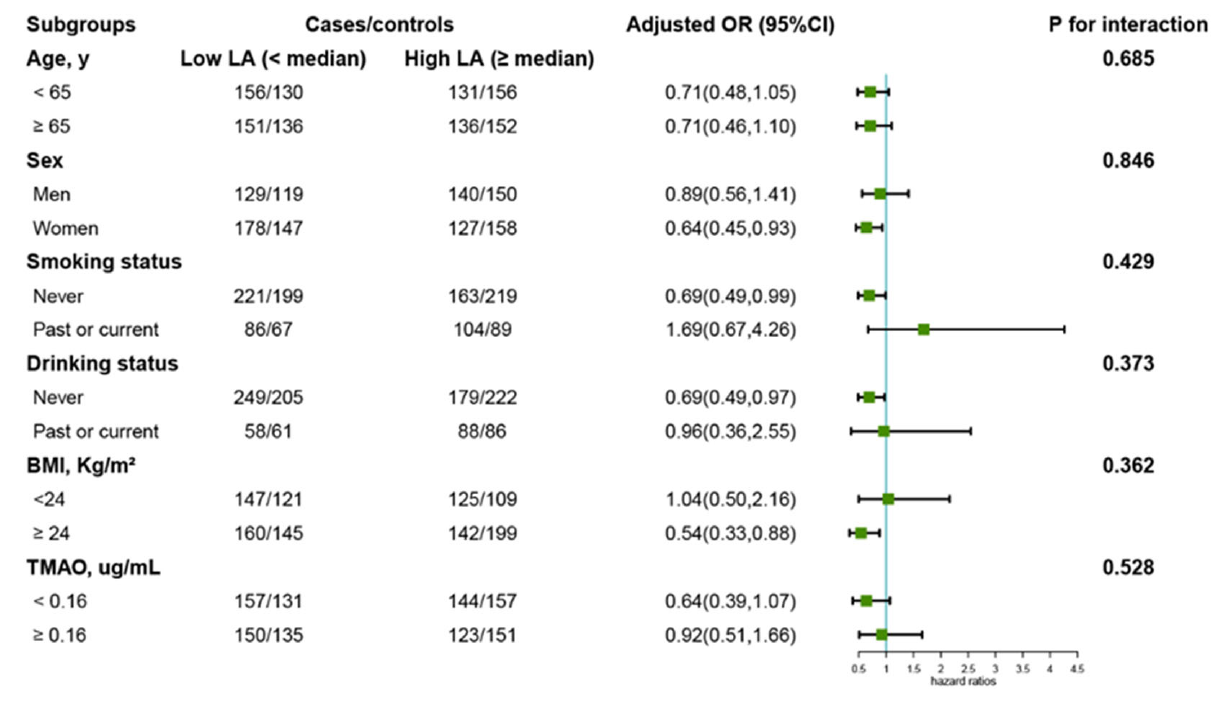
Figure 3. Stratified analysis of the association of serum LC with the risk of overall cancer. Note: Models were adjusted for ALT, ALB, BMI, smoking status, alcohol drinking, SBP, TC, TG, UA, HDL-C, glucose, creatinine, sleep quality, meat consumption frequency, type of meat consumed, TMAO, oral antihypertensive medication usage, and family history of cancer, except for the stratified factors. In the mediation analysis, we found a significant direct effect of LC concentrations on occurrence of overall, digestive system, and non-digestive system cancer. However, the indirect effect (the effect of the LC on the TMAO multiplied by the effect of the TMAO on the Table 4. The association of TMAO with overall cancer risk. cancer risk) and the mediation effect were not significant. The serum TMAO concentrations did not mediate the reversed association of LC with the risk of overall, digestive system, and non-digestive system cancer (Figure